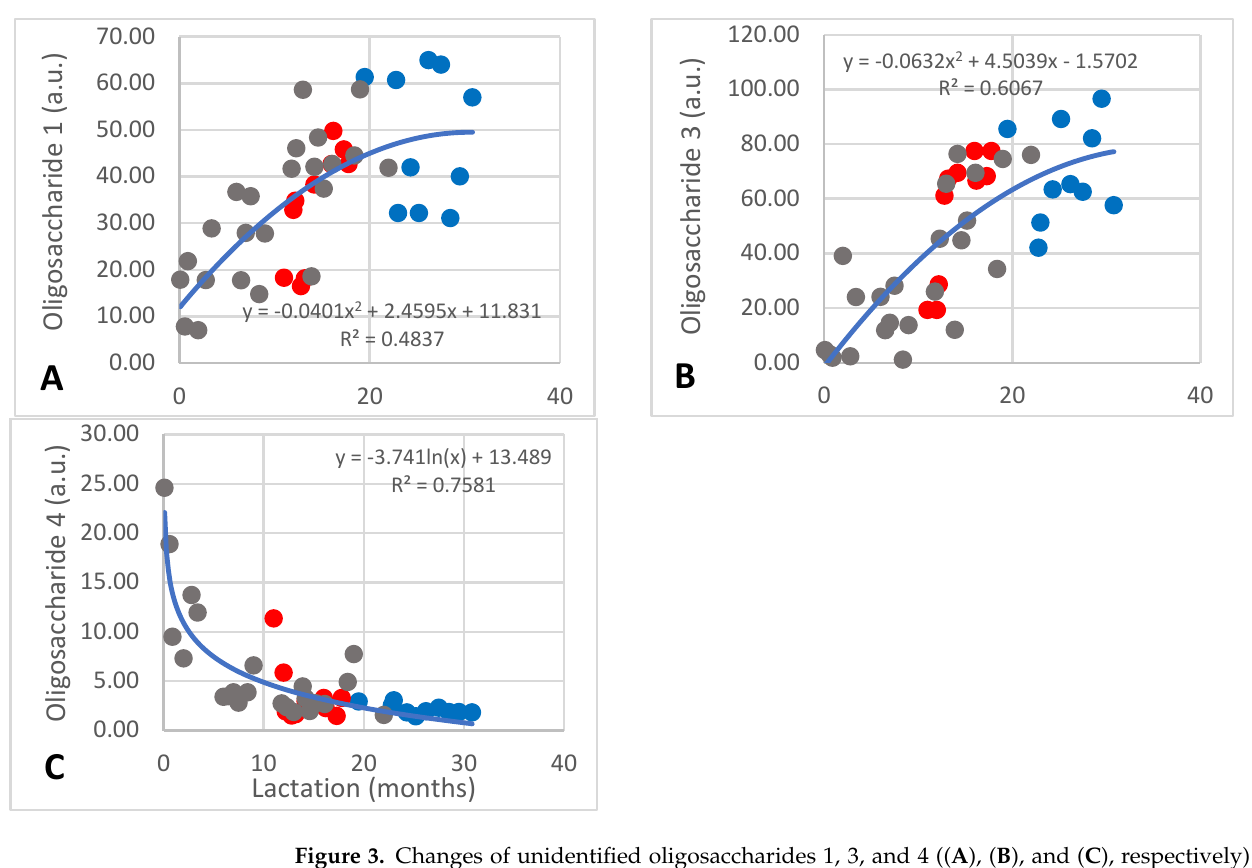
Figure 2. Changes of identified saccharides: lactose ( A ), total identified oligosaccharides ( B ), lacto ‐ N ‐ difucohexaose I ( C ), 3 ′‐ sialyllactose ( D ), 2 ′‐ fucosyllactose ( E ), and 3 ‐ fucosyllactose ( F ) and difu ‐ cosyllactose ( G ) in milk of African elephants (Shorty ● , Mussina ● , Shan ● ). Trend lines, formulas, and R 2 values were calculated from the combined data of the three elephants.